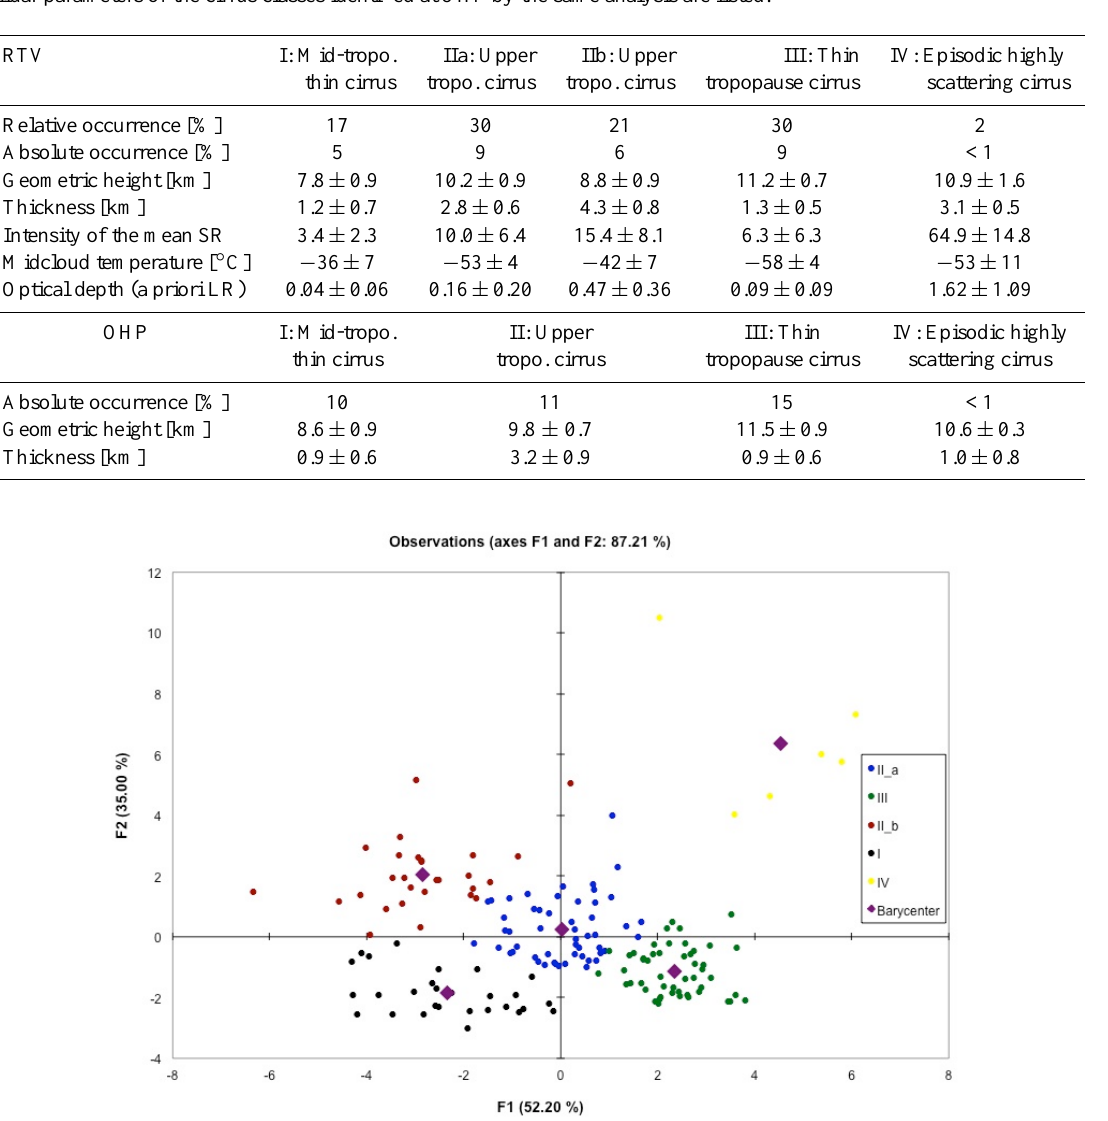
Fig. 3. Cirrus parameters represented (projected) on the two sets of orthogonal axes identified by the DFA, which describe the 87.21% of the cirrus characteristics. Colored dots identify the different classes discriminated by HCM, while the violet diamonds represent the barycenter of each class.